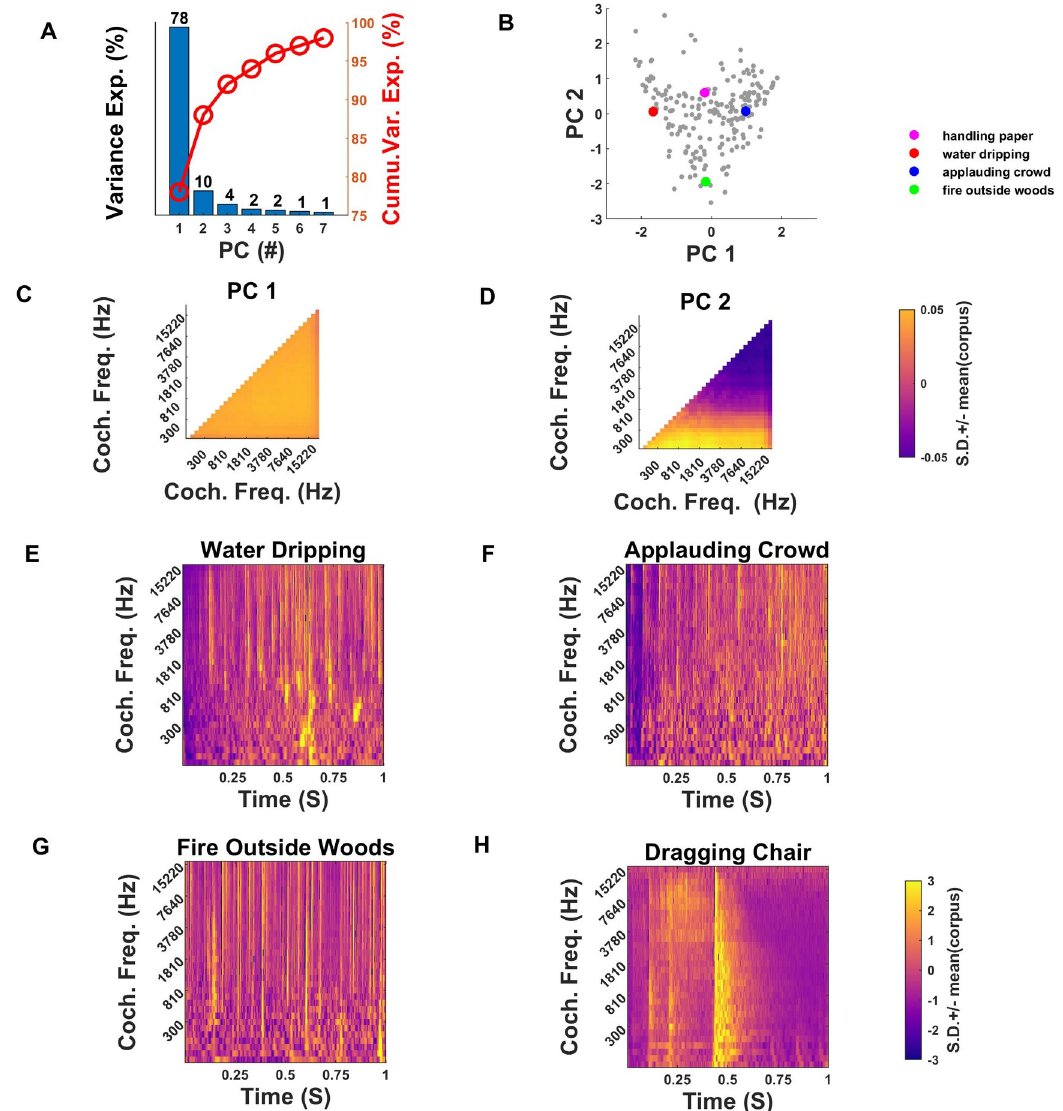
Fig 7. Principal components of cochlear correlation parameters. (A) The first PC alone captures ~78% of variance, whereas the second PC captures merely 10% and higher PCs capture only very small proportions of the variance. Together PC1 and PC2 show cumulative variance of 88%, as shown by the red line. (B) Coordinates of all sound textures in our corpus along the principal components of cochlear correlations. Colored dots represent four example sounds examined further in panels E-H. (C) PC1 shows elevated correlation across all pairs of cochlear frequencies, and thus distinguishes “highly correlated” from “poorly correlated” sounds. (D) PC2 captures whether correlations are more pronounced among low or high frequencies. (E-H) normalized cochleagrams for the four sound texture examples highlighted in (B) by colored